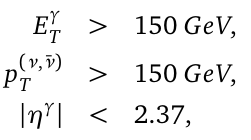
(cid:112) s = 14 TeV